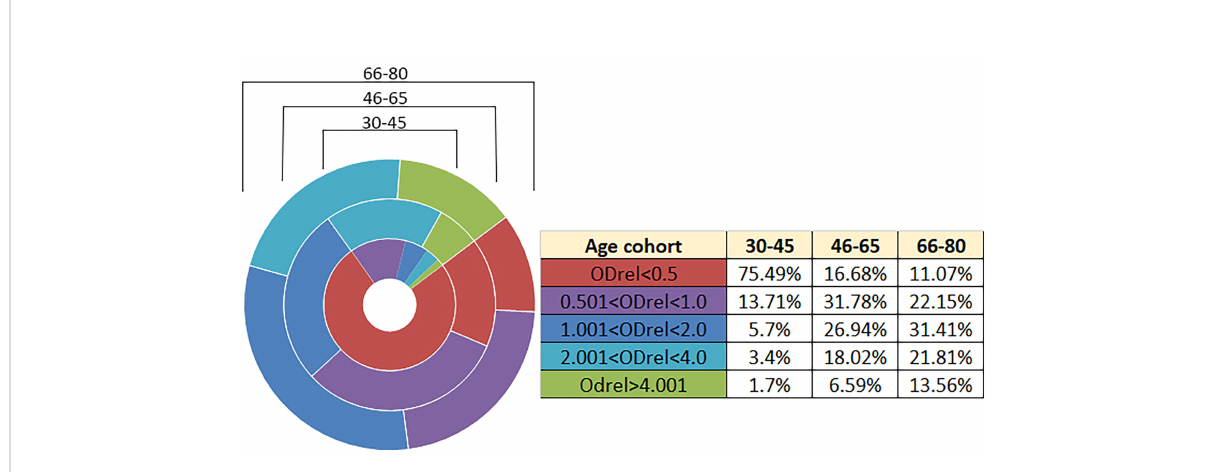
FIGURE 1 Antibody levels according to age. n = 2908. The relative optical density (ODrel) was calculated for each serum sample, dividing the OD-450 of the sample by the average value of OD-450 K+ (weakly positive control) in this experiment. The obtained values were conditionally divided into 5 groups: negative (ODrel <0.5), doubtful (0.501 < ODrel < 1.0), weakly positive (1.001 < ODrel. < 2.0), positive (2.001 < ODrel. < 4.0) and highly positive (ODrel > 4.001). Percentages have statistically signi fi cant differences in any comparisons between ages (max p = 0.031). The maximum percentage of samples obtained from people 30-45 years old showed a negative result in ELISA ((ODrel <0.5), most samples from people 46-65 years old showed doubtful result and the largest number of samples from people 66-80 years old showed a weakly positive